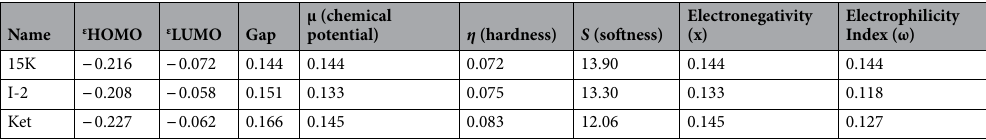
Table 3. Results of quantum chemical calculations of 15K, ketorolac, and inhibitor 2. Ket Ketorolac, I-2 Inhibitor 2; All values are expressed in Hartree.